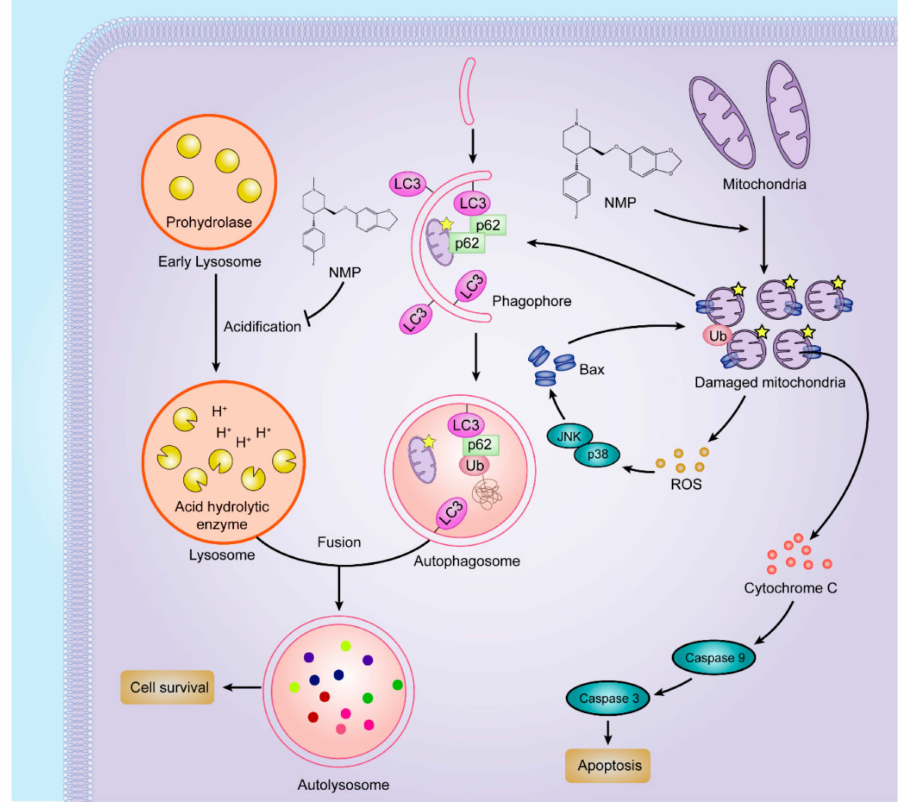
Figure 9. NMP induced apoptosis in NSCLC cells by dual pathways. An illustration demonstrating the summary of NMP actions on apoptosis in NSCLC cells. ( Left ) NMP inhibited late-staged autophagy flux by inhibiting acidification of early lysosome. ( Right ) NMP stimulated mitochondrial fission and fragmentation, leading to ROS and cytochrome C leakage. Cytochrome C is a risk factor to promote apoptosis. Excessive ROS accumulation further damages mitochondria, thus NMP could induce an e ff ective apoptotic e ff ect on tumor cells by promoting mitochondrial-dependent apoptosis and inhibiting autophagy in NSCLC cells in